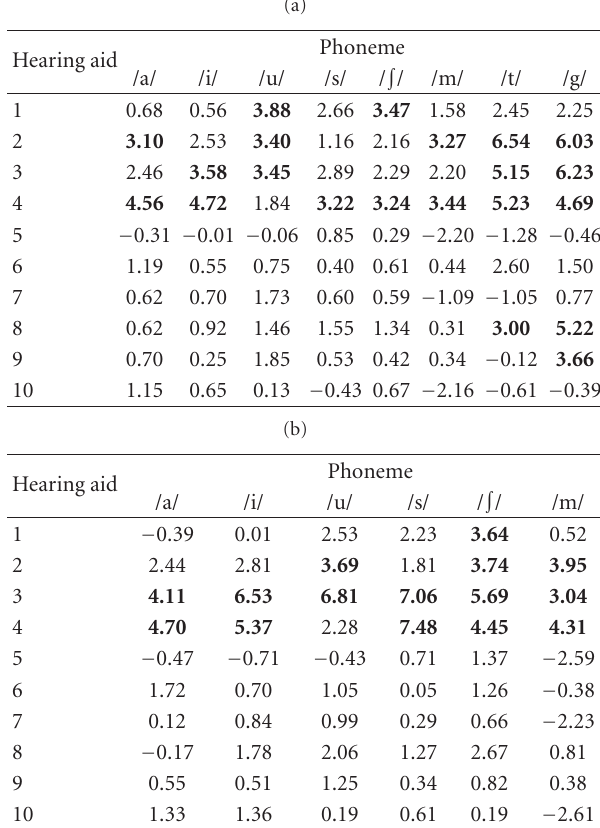
Table 5: (a) Di ff erence (dB) in overall phoneme level averaged across input levels (positive value indicates higher overall phoneme level in running speech). (b) Di ff erence (dB) in phoneme onset level averaged across input levels (positive value indicates higher phoneme onset level in running speech).